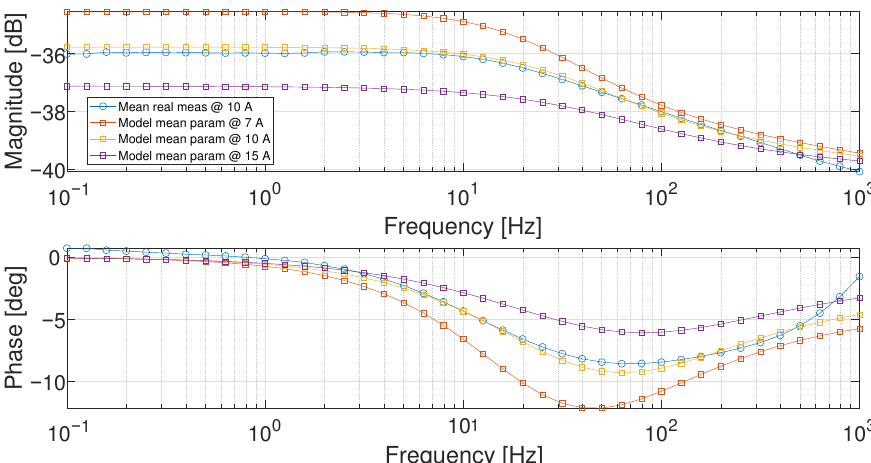
Figure 18. Bode diagram comparison between the averaged experimental measurement at 10A (circle marked) and the averaged models at 7A, 10A and 15A,